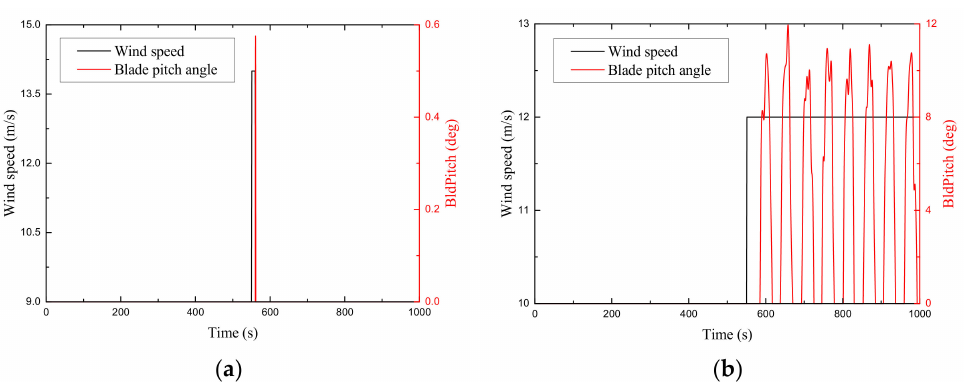
Figure 6. Blade pitch angle control with the wind speed varying: ( a ) Steady-state wind with a pulse; ( b ) Steady-state wind with a